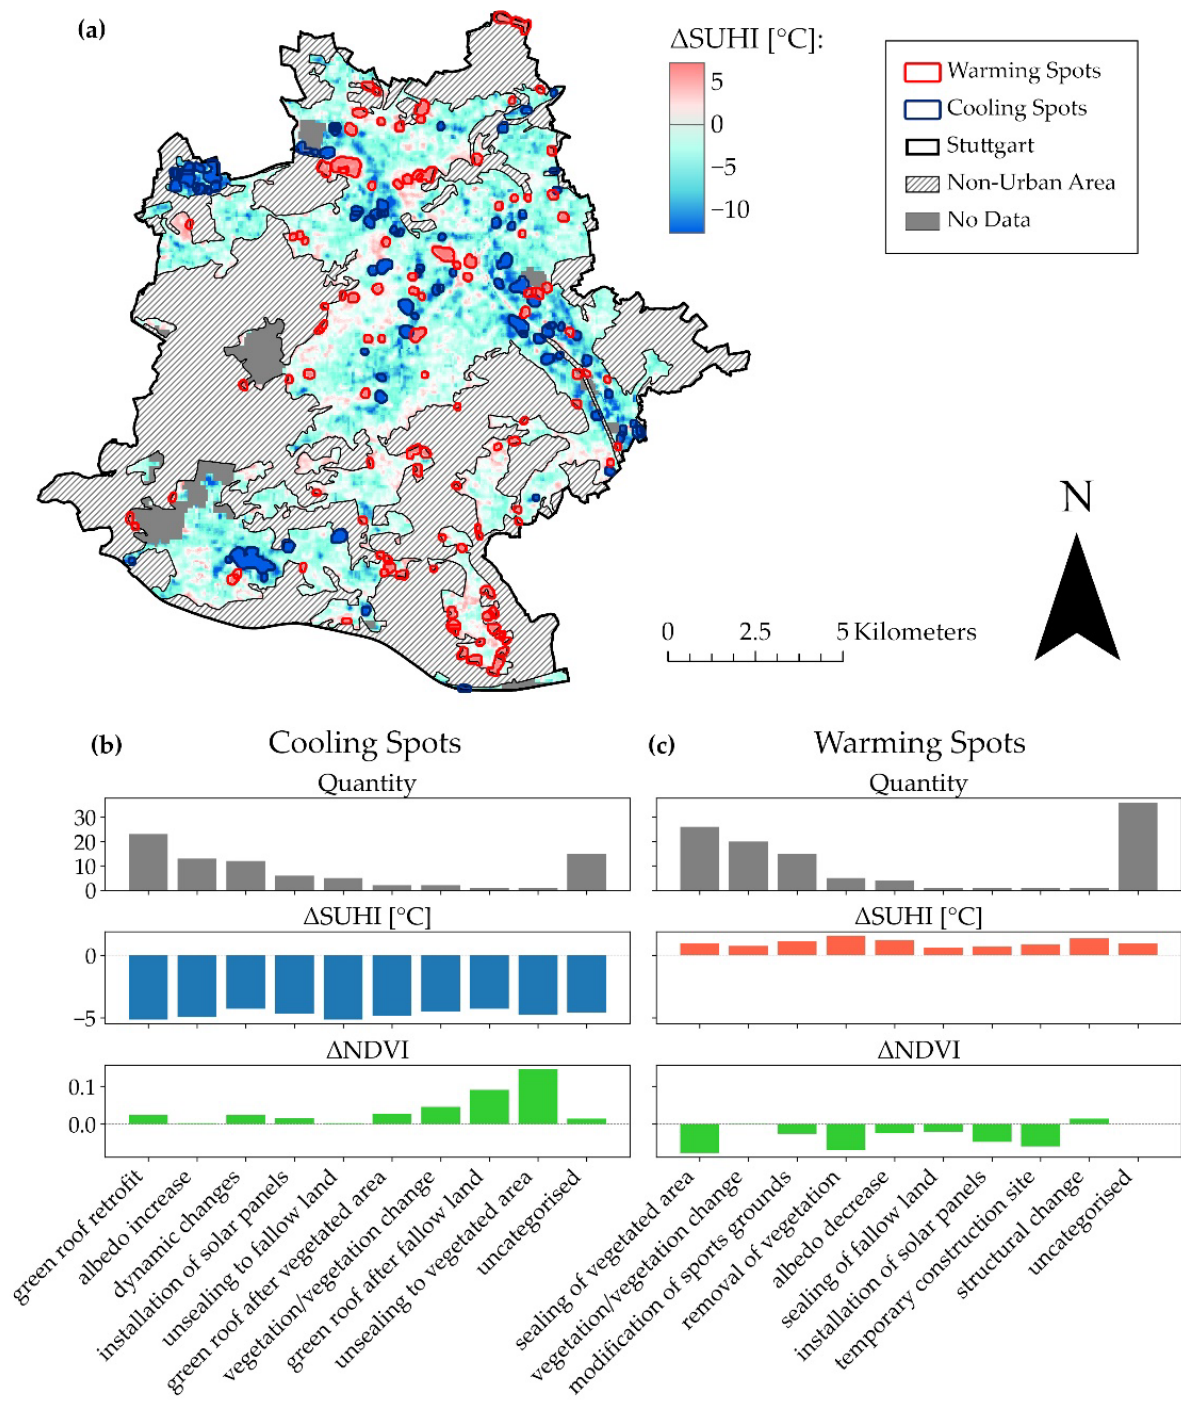
Figure 4. ( a ) Change in the surface urban heat island ( ∆ SUHI) in the urban area of Stuttgart between the five-year averages of 2004–2008 and 2016–2020, with highlighted extreme spots of ∆ SUHI. Extreme warming (cooling) spots are defined as pixels above the 98th (below the 2nd) percentile of the spatial ∆ SUHI distribution. Categorisation of the ( b ) cooling spots and ( c ) warming spots according to the predominant land cover changes and the respective changes in SUHI and Normalised Difference Vegetation Index (NDVI).